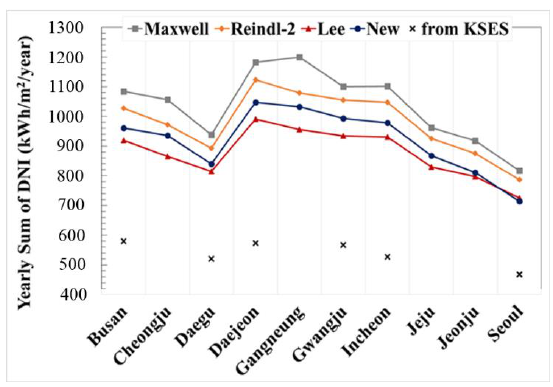
Figure 8. Yearly sums of the GHI from the long-term mean, in the TMY data from Korean Solar Energy Society (KSES), and in the TMY data generated using the Maxwell, the Reindl-2, and the new models. Figure 9. Yearly sums of the DNI in the TMY data from KSES and in the TMY data generated using the Maxwell, the Reindl-2, and the new models.